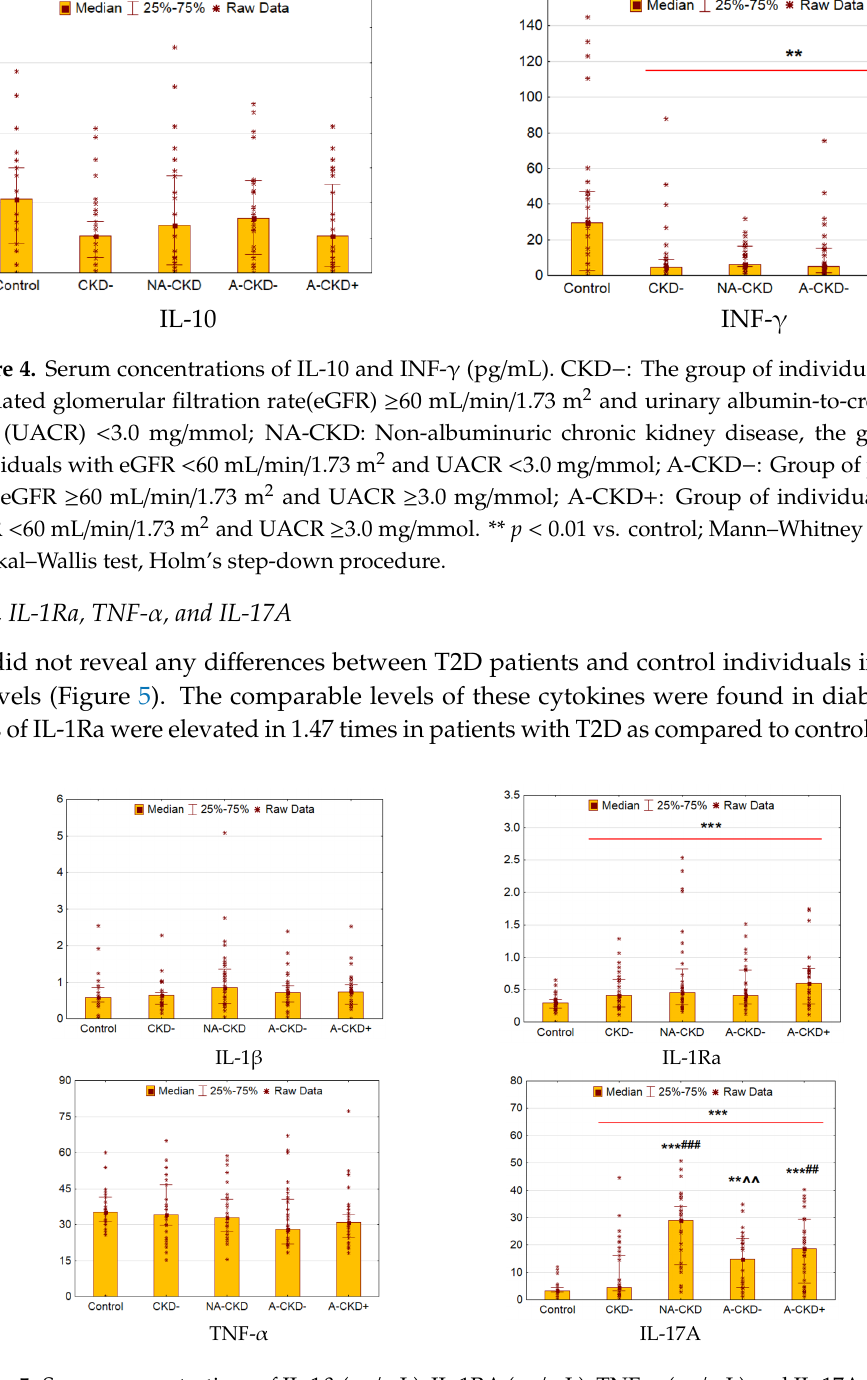
Figure 5. Serum concentrations of IL-1 β (pg/mL), IL-1RA (ng/mL), TNF- α (pg/mL) and IL-17A (pg/mL). CKD − : The group of individuals with estimated glomerular filtration rate (eGFR) ≥ 60 mL/min/1.73 m 2 and urinary albumin-to-creatinine ratio (UACR) <3.0 mg/mmol; NA-CKD: Non-albuminuric chronic kidney disease, the group of individuals with eGFR <60 mL/min/1.73 m 2 and UACR <3.0 mg/mmol; A-CKD − : Group of patients with eGFR ≥ 60 mL/min/1.73 m 2 and UACR ≥ 3.0 mg/mmol; A-CKD+: Group of individuals with eGFR <60 mL/min/1.73 m 2 and UACR ≥ 3.0 mg / mmol. ** p < 0.01, *** p < 0.001 vs. control, ## p < 0.01, ### p < 0.001 vs. CKD − ; ˆˆ p < 0.01 vs. NA-CKD; Mann–Whitney and Kruskal–Wallis test, Holm’s step-down